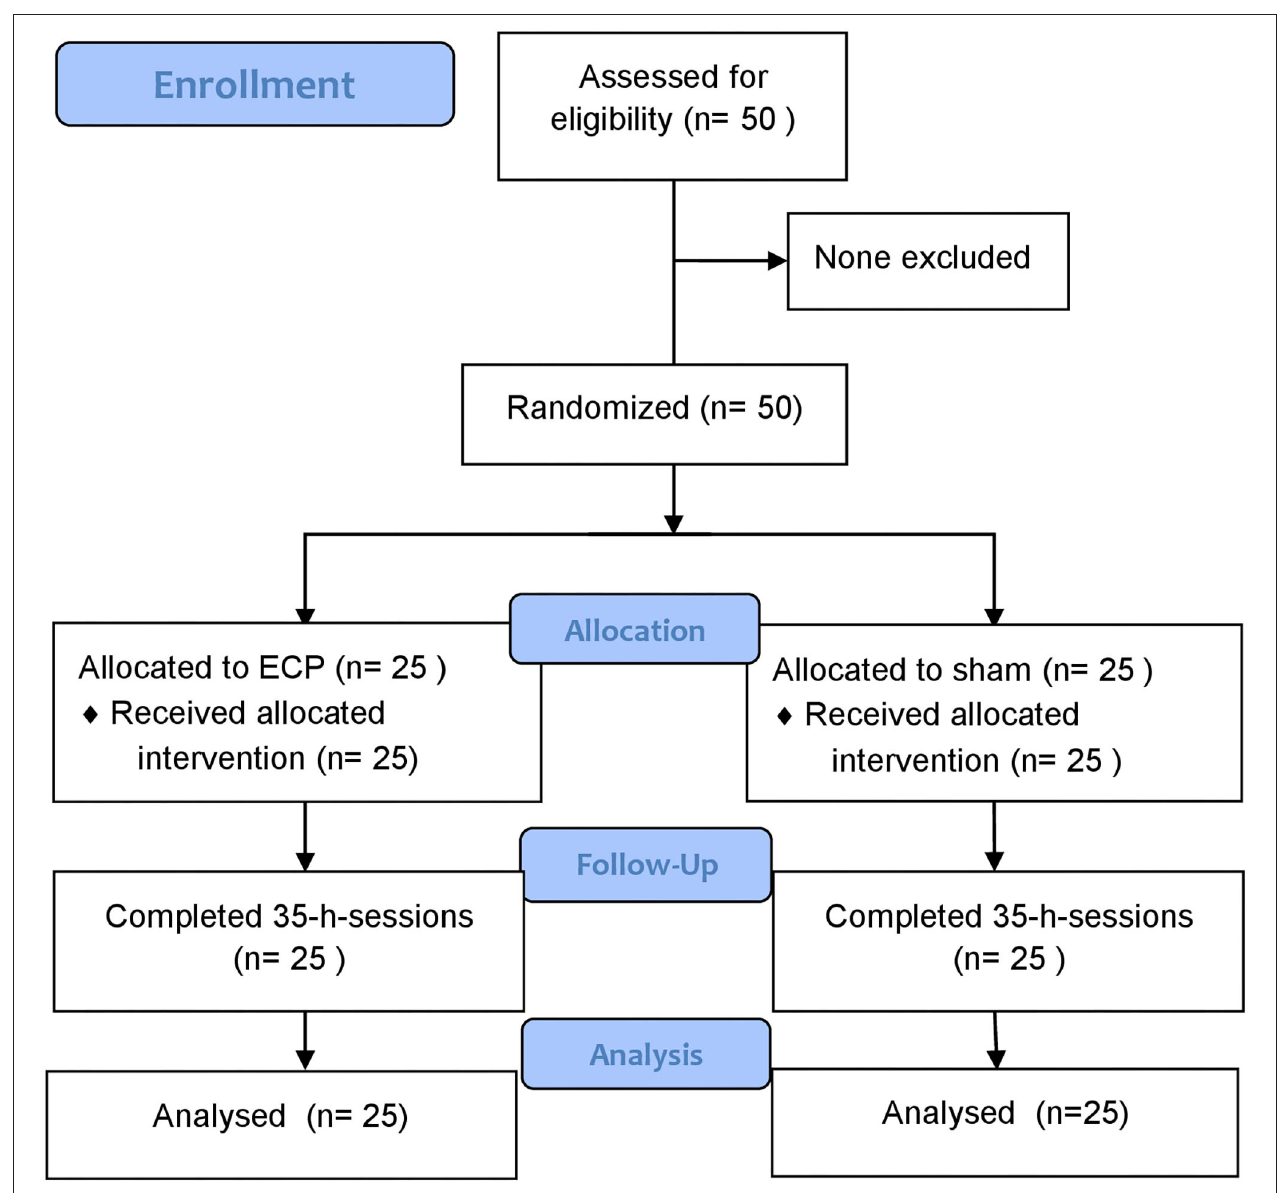
FIGURE 1 | CONSORT flow